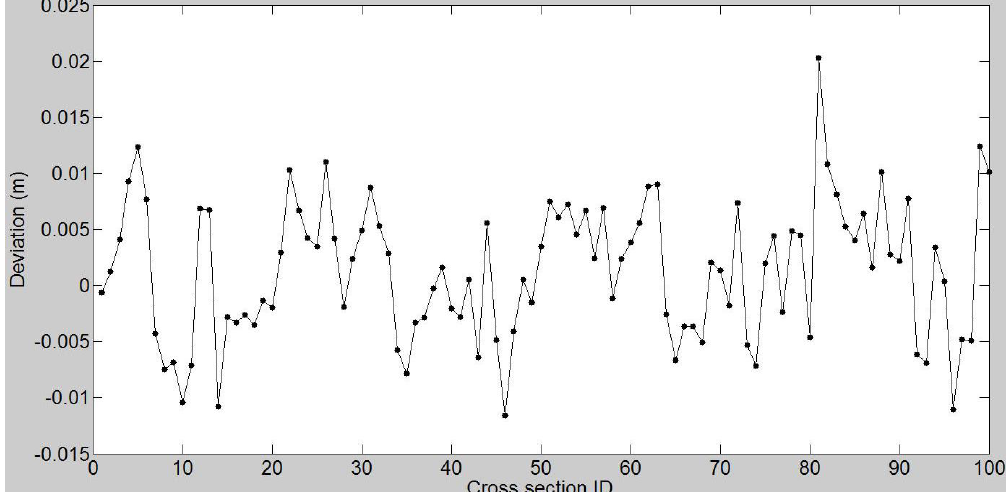
Figure 17. Deviations between the fitted radii and the designed